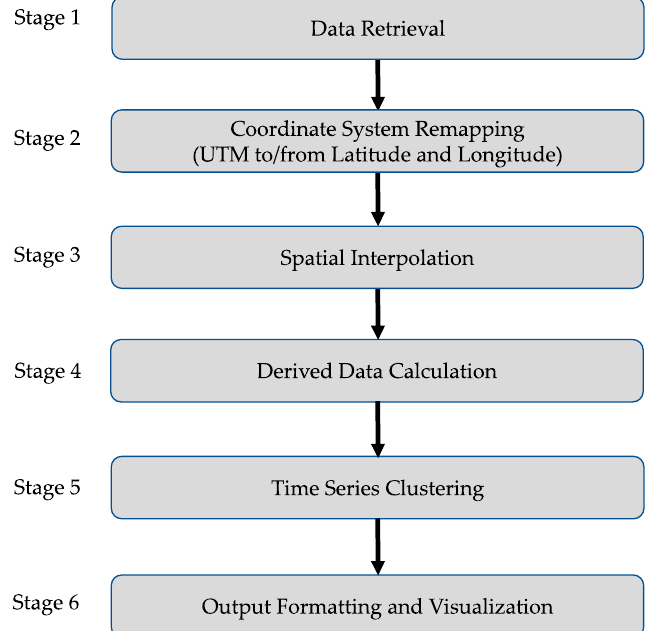
Figure 1. Data processing flow showing the 6 stages of data manipulation, starting with data retrieval from dataset source to final data output generation and visualization.